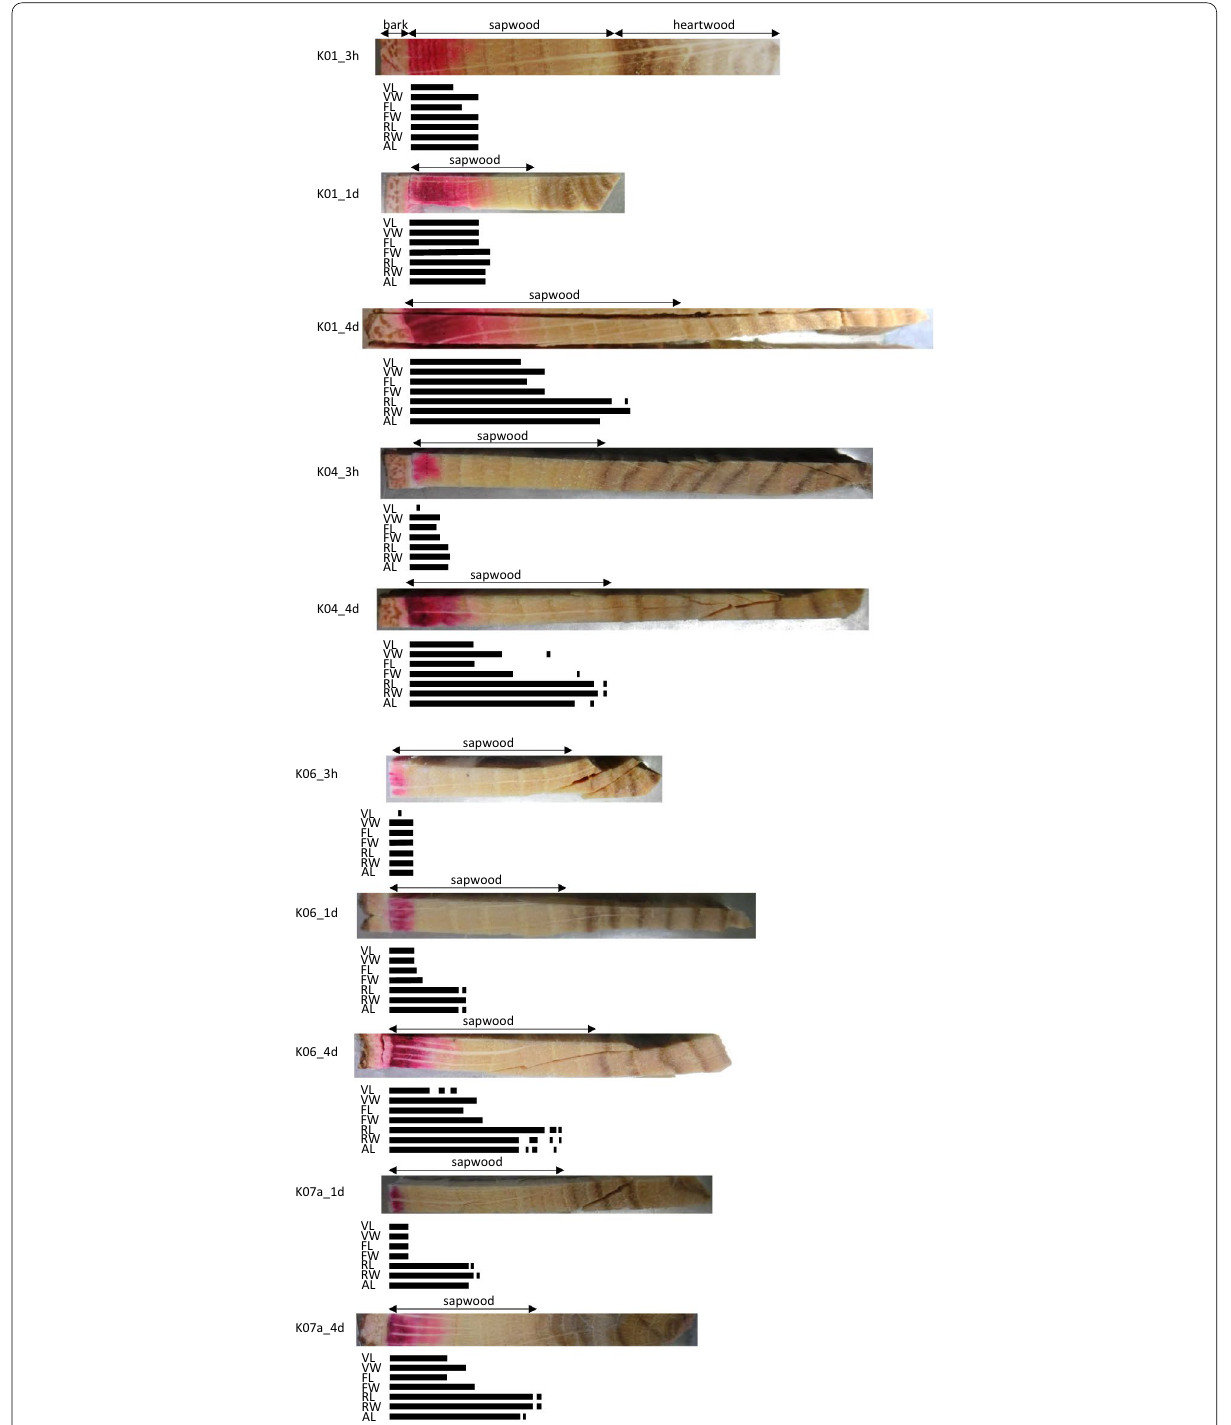
Fig. 2 Schematic representation of the radial distribution of cesium (Cs) in the xylem of normal konara oak ( Quercus serrata ) trees after 3-h, 1-day, or 4-day injection, as observed using cryo-scanning electron microscopy/energy-dispersive X-ray spectroscopy (cryo-SEM/EDX). Bars below each sample image represent the areas where Cs was detected. VL, vessel lumen; VW, vessel cell wall; FL, fiber lumen; FW, cell wall between fibers; RL, ray parenchyma cell lumen; RW, cell wall between ray parenchyma cells; AL, axial parenchyma cell